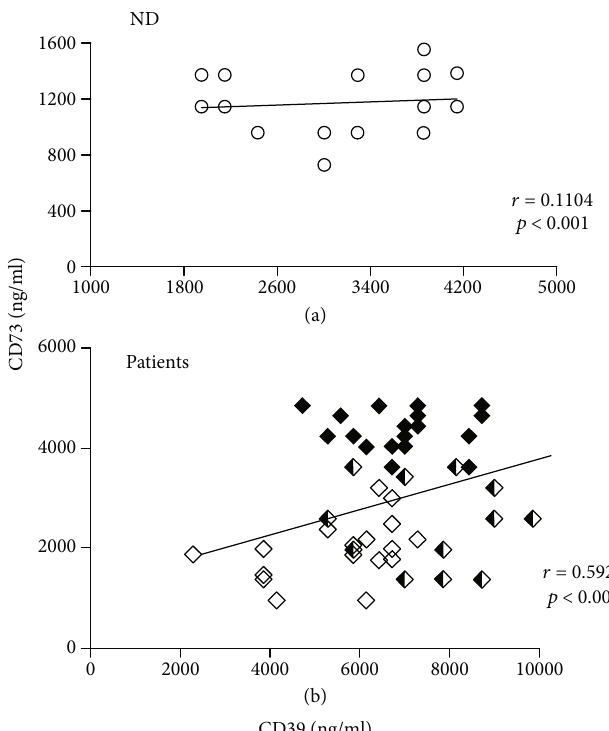
Figure 2: Correlations between the concentrations of CD39 and CD73 in the PFP of NDs and in the PFP of patients (LSILs, HSILs, and CC together). The correlations ( r ) between the concentrations of CD39 and CD73 in the ND PFP samples (open circles) are shown ( r = 0 : 1104 , p < 0 : 001 ) (a), as well as the correlations for patients with LSILs (white diamonds), HSILs (black and white diamonds), and CC (black diamonds) (b) ( r = 0 : 5929 , p < 0 : 001